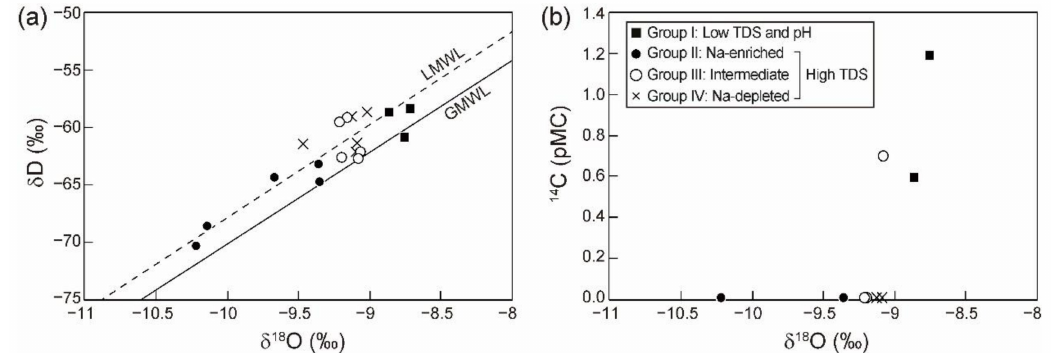
Figure 4. Isotopic compositions. ( a ) Plot of δ 18 O versus δ D values (n = 18). The solid and dashed line are the global meteoric water line ( δ D = 8 × δ 18 O + 10 [48]) and the local meteoric water line ( δ D = 8.06 × δ 18 O + 12.87 [49]), respectively. ( b ) Plot of 14 C contents versus δ 18 O (n = 9). Table 3. Isotopic compositions of water samples from the CO 2 -rich springs in the northern part of the GSB. The CO 2 -rich springs are grouped based on pH, TDS, and Na contents in Figure 2. Group I: dilute and acidic CO 2 -rich water; Group II: “Na-enriched” Ca-HCO 3 type water; Group III: